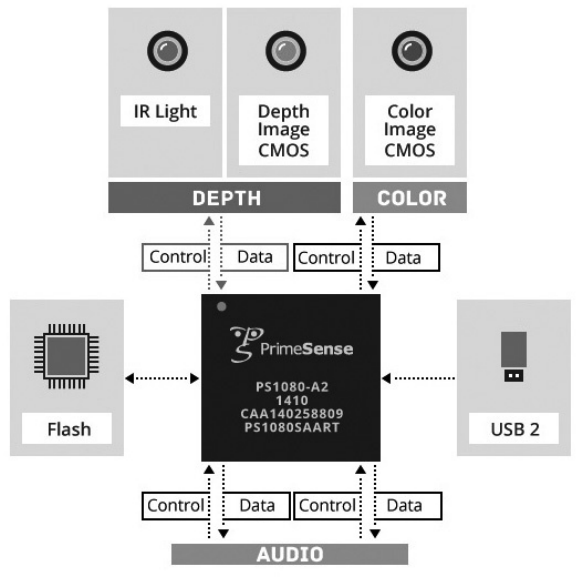
Figure 2: Elektronic components of a Carmine